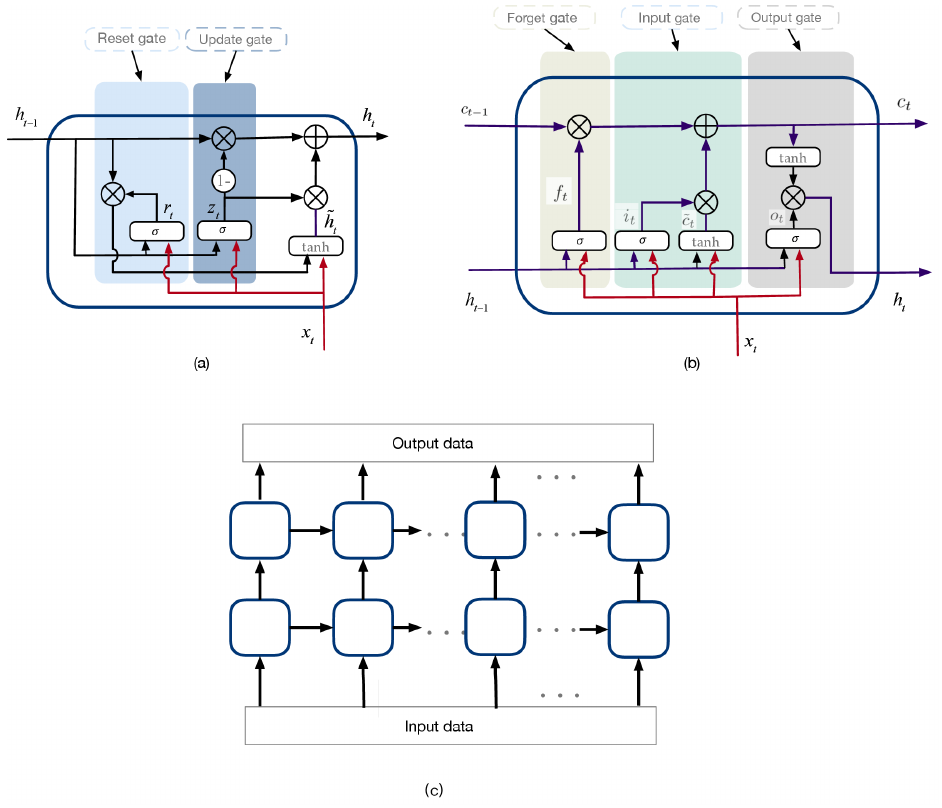
Figure 4. Data-driven model. ( a ) GRU cell; ( b ) LSTM cell; ( c ) deep learning